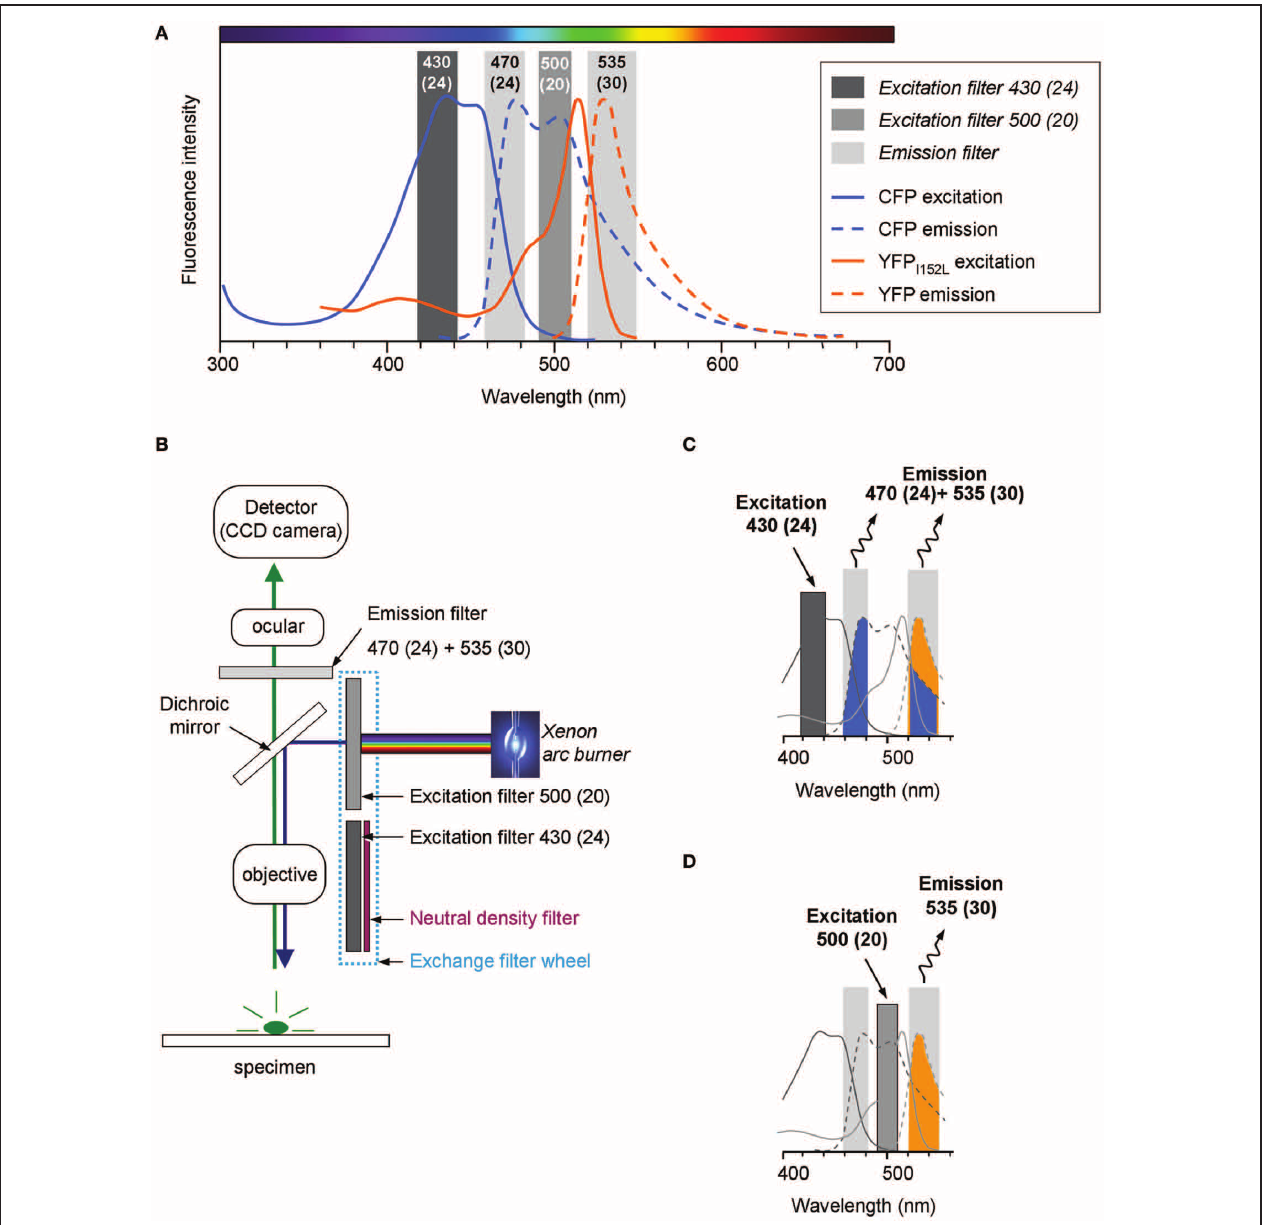
FIGURE 1 | Light pass of conventional epifluorescence setup. (A) Excitation and emission spectra of the filter set used in the study (vertical bars) overlapped with emission and excitation spectra for cyan and yellow fluorescent proteins carrying the I152L mutation (CFP and YFP I152L